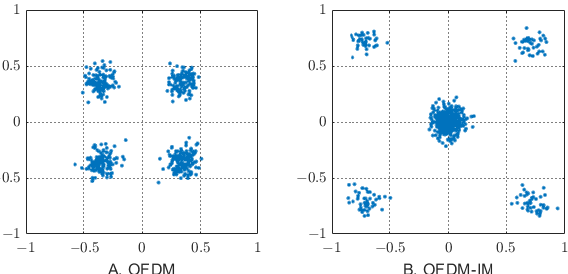
Figure 4. Comparison of the constellation diagrams between conventional ( A ) OFDM and ( B ) OFDM-IM. The upper bound of the BER for OFDM-IM is obtained from the joint-bind